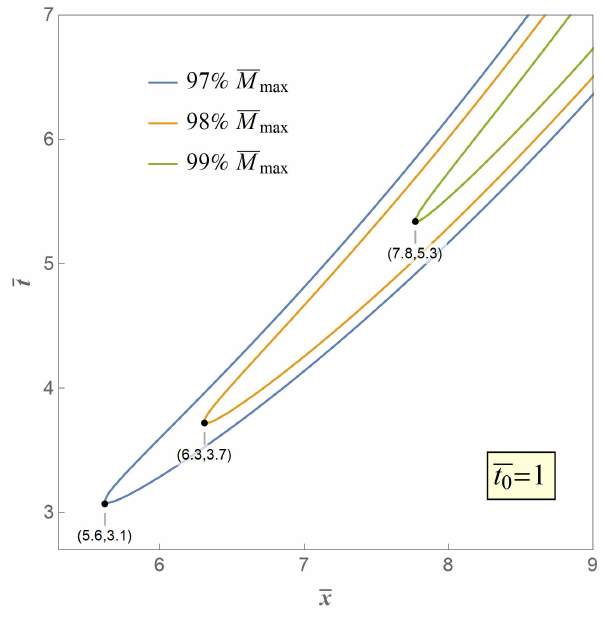
Figure 7. Contour curves when M = 97%,98%,99% M max at t 0 = 1.